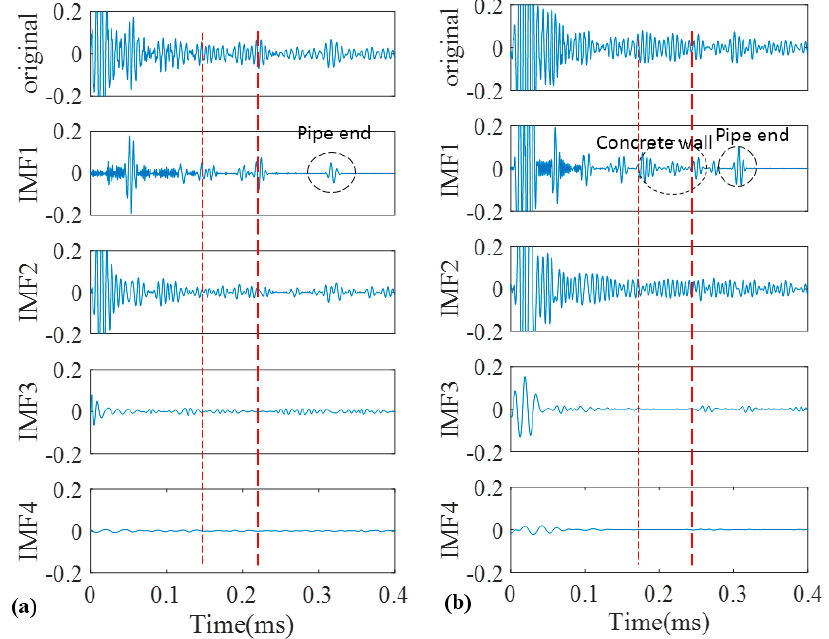
Figure 13. Decomposition of signals into their IMFs by EEMD for the pristine pipe ( a ); and the pipe with a natural corrosion ( b ).